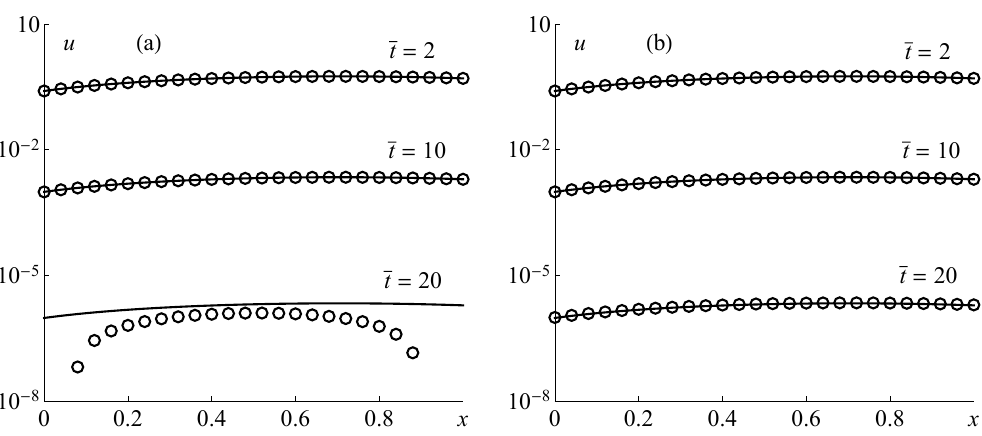
Figure 3. The exact solutions (solid lines) and numerical solutions obtained by the combination of the method of lines and the second-order implicit Runge–Kutta method (circles) of test problem 1 for a = 1, k = 0.5, s = 0.2, and N = 100 at different times ¯ t = t / τ for two delays: ( a ) τ = 0.05 and ( b ) τ =